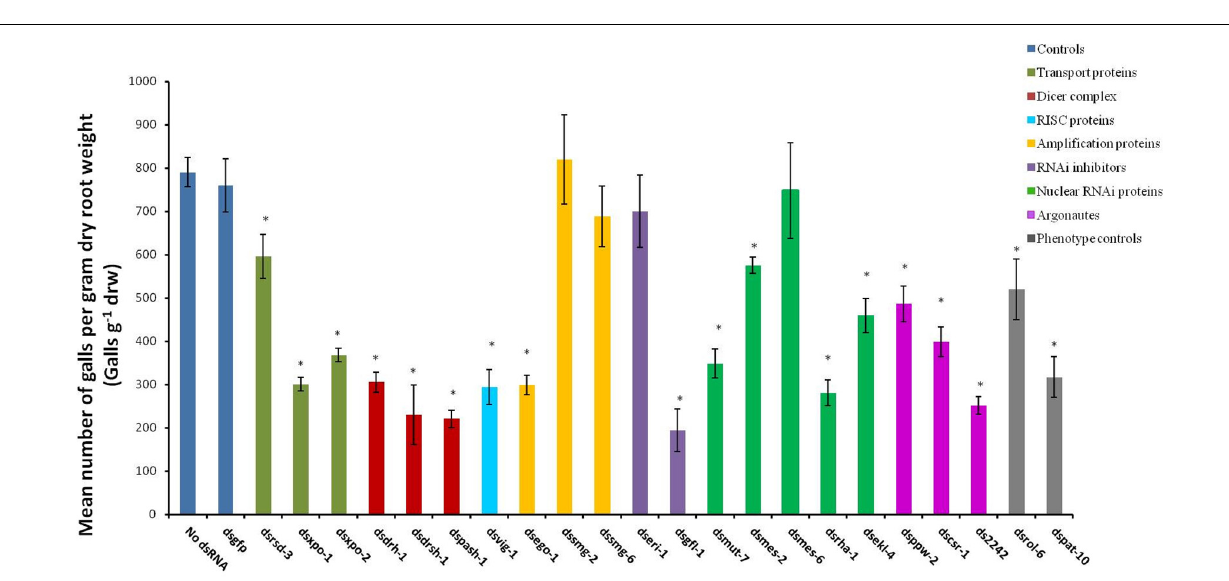
FIGURE 3 | Mean number of galls per gram of dry root of tomato plants inoculated with M. incognita J2s 16 h after the nematodes were soaked in dsRNA of target genes. Dsgfp and no dsRNA treatments were used as controls. Different colored bars represent different groups of genes involved in the small RNA pathway of the nematode. Bars represent means ( n = 7) ± standard error with significant differences between the means and those of the no-dsRNA controls indicated with ( ∗ p <